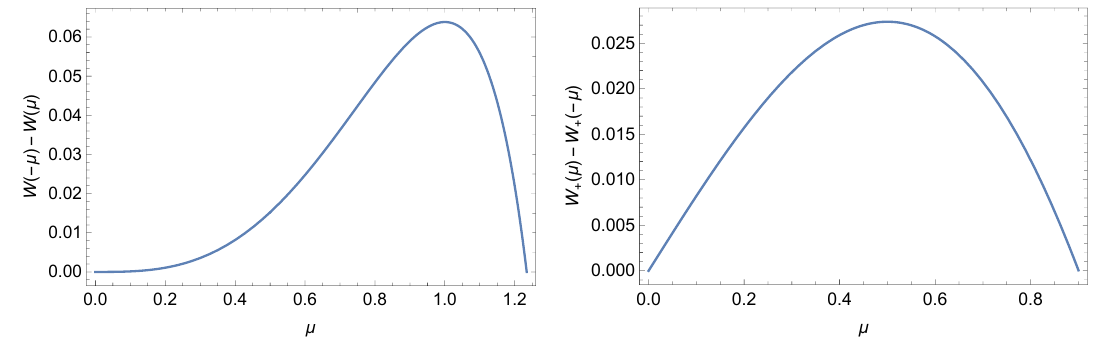
Figure 1 . (Left) The di(cid:11)erence W ( (cid:0) (cid:22) ) (cid:0) W ( (cid:22) ) as a function of (cid:22) in 4d for a free scalar. The curve crosses the (cid:22) axis at approximately 1 : 23423. (Right) The di(cid:11)erence W + ( (cid:22) ) (cid:0) W + ( (cid:0) (cid:22) ) as a function of (cid:22) in 4d for a free fermion. The curve crosses the (cid:22) axis at approximately 0 : 90. The regularized log of the partition function